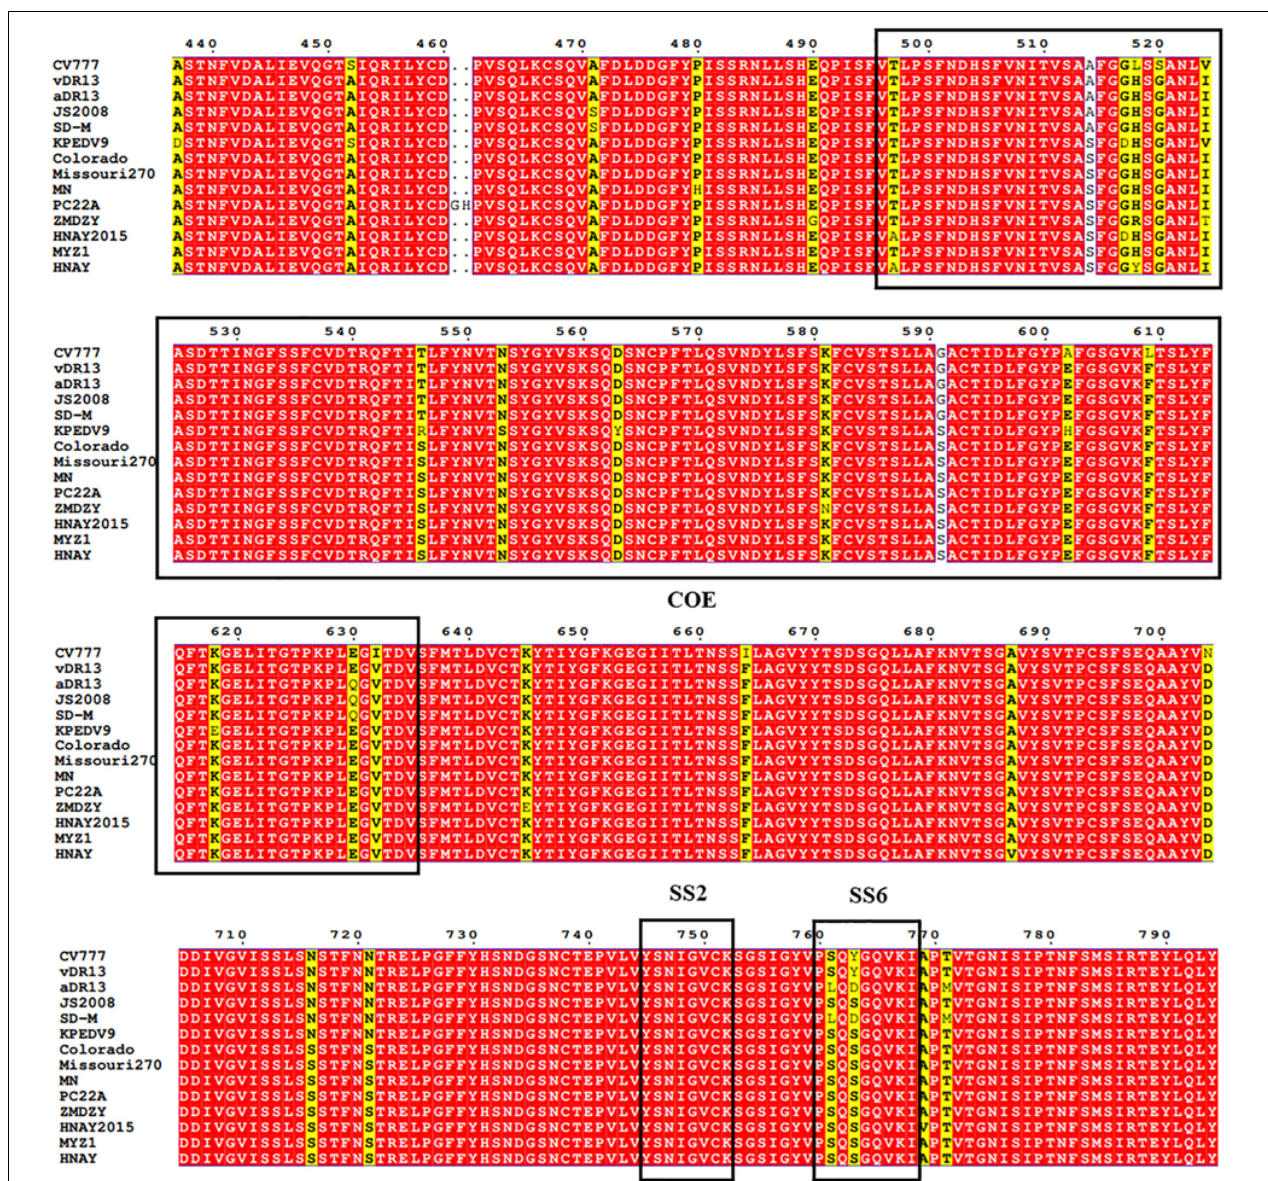
FIGURE 4 | The neutralizing epitopes analysis of S protein of PEDV HNAY with reference strains. The positions of COE, SS2, and SS6 are shown in black